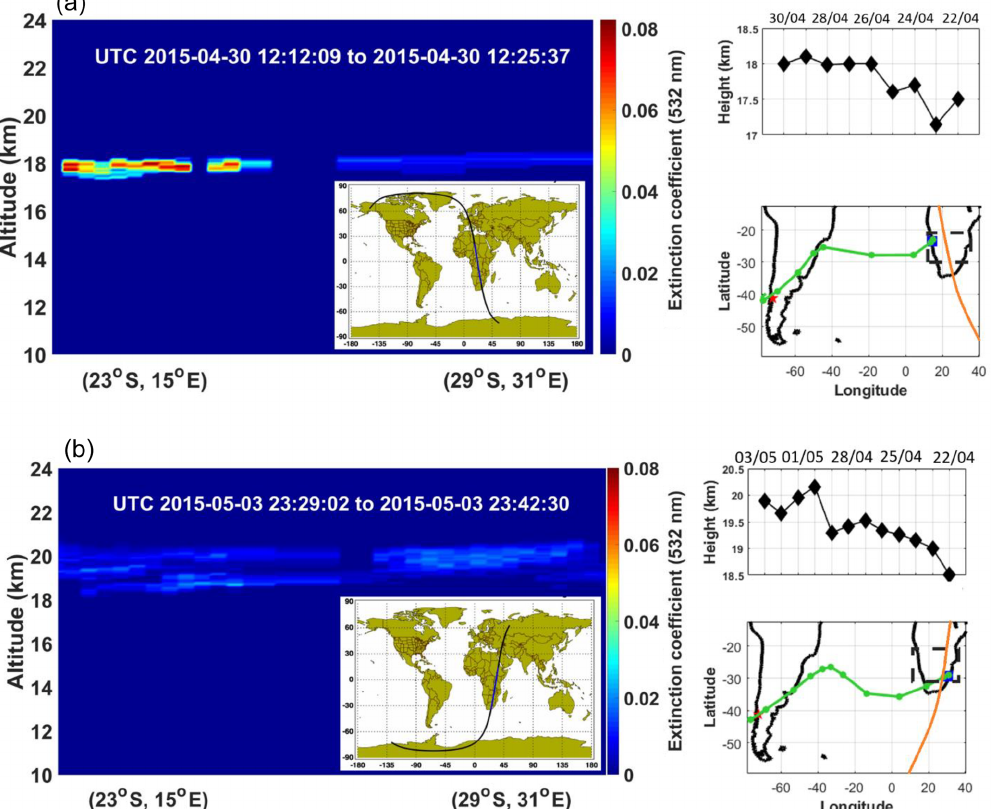
Figure 3. Daily zonal extinction coefficient values (km − 1 ) at 532nm observed by CALIOP over the South African region on (a) 30 April and (b) 3 May. The red star and the blue square correspond to the location of the Calbuco volcano and the maximum extinction values respectively. Back-trajectory analysis between the maximum extinction values and the Calbuco volcano is represented by the green curve. The CALIPSO overpass trajectories are plotted by the orange